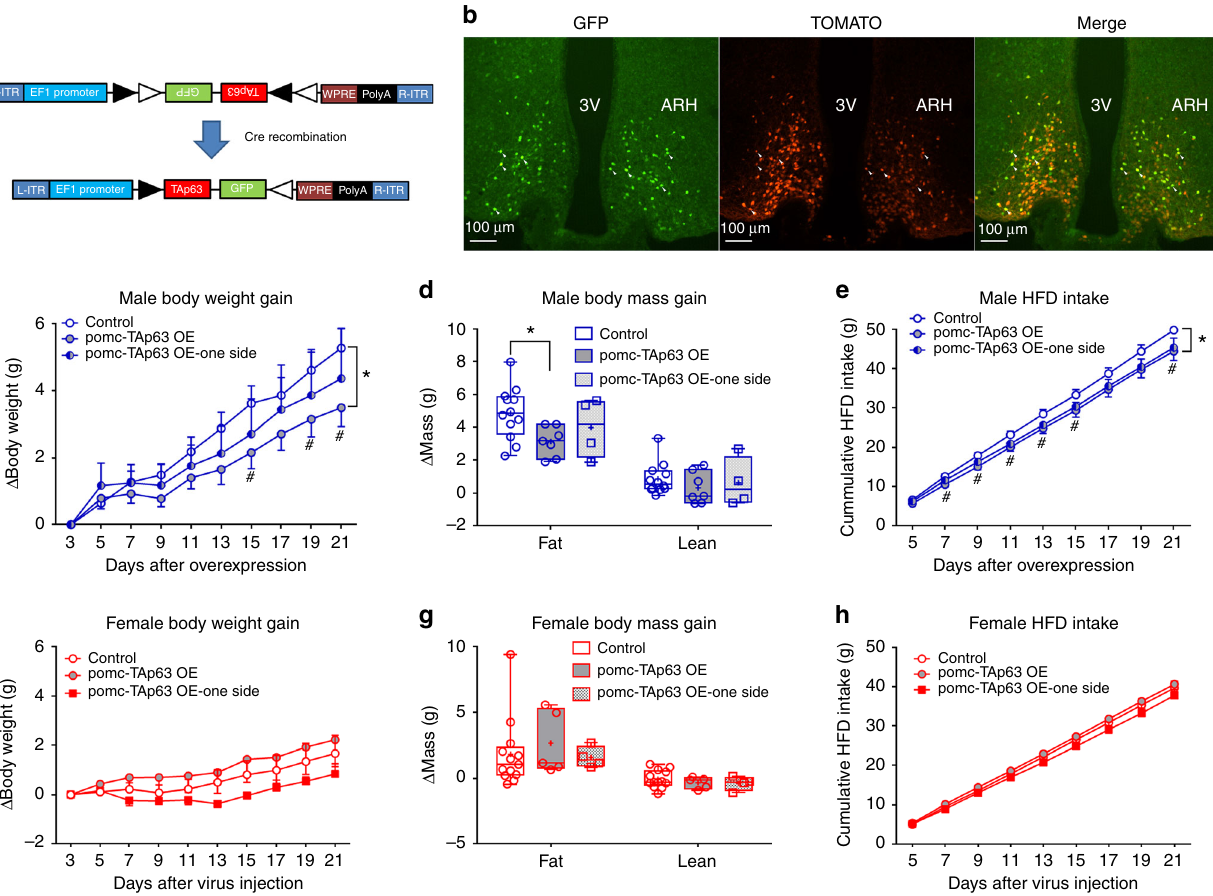
Fig. 5 Selective overexpression of TAp63 in POMC neurons reduces the body weight of male HFD-fed mice. a Schematic construction of AAV vector, AAV-FLEX-TAp63-2A-GFP. b Immuno fl uorescent images showing GFP (left panel), TOMATO (middle panel), and merge (right panel) in POMC neurons of POMC-Cre/Rosa26-tdTOMATO mice receiving AAV-FLEX-TAp63-2A-GFP stereotaxically injected in the ARH bilaterally. The majority of GFP-labeled neurons are TOMATO-positive; only a few double-labeled neurons are pointed by arrowheads for a better view. 3 V, 3rd ventricle; ARH, arcuate nucleus of the hypothalamus. c Changes in body weight in HFD-fed male mice. Data are presented as mean ± SEM. N = 7 or 12 in control or OE group; N = 4 in one side group. * P < 0.05 between groups and # P < 0.05 between the control and pomc-TAp63 OE groups at each time point in two-way ANOVA followed by post hoc Sidak tests. d Changes in the fat and lean mass in HFD-fed male mice. Data are presented as box and wiskers showing minimal, maximal, and median values with individual data points. N = 7 or 12 in control or OE group; N = 4 in one side group. * P < 0.05 in two-way ANOVA followed by post hoc Sidak tests. e Cumulative HFD intake in HFD-fed male mice. Data are presented as mean ± SEM. N = 7 or 12 in control or OE group; N = 4 in one side group. * P < 0.05 between groups and # P < 0.05 between the control and pomc-TAp63 OE groups at each time point in two-way ANOVA followed by post hoc Sidak tests. f Changes in body weight in HFD-fed female mice. Data are presented as mean ± SEM. N = 5 or 13 in control or OE group; N = 4 in one side group. g Changes in the fat and the lean mass in HFD-fed female mice. Data are presented as box and wiskers showing minimal, maximal, and median values with individual data points. N = 5 or 13 in control or OE group; N = 4 in one side group. h Cumulative HFD intake in HFD-fed female mice. Data are presented as mean ± SEM. N = 5 or 13 in control or OE group; N = 4 in one side